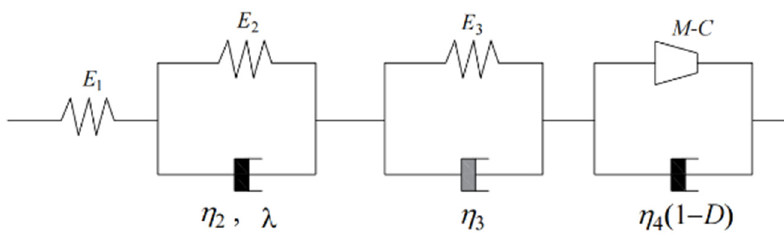
Figure 1. Nonlinear viscoelastic plastic damage creep mechanical model.